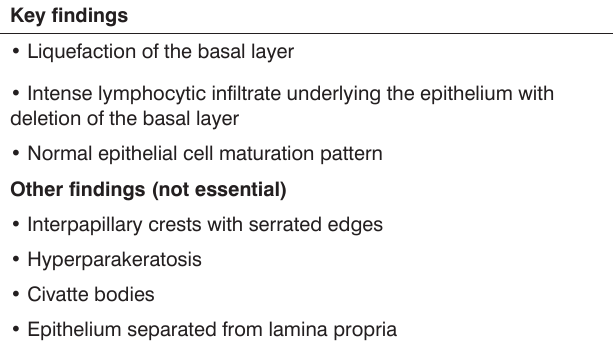
Table 1. Histological diagnostic criteria for oral lichen planus. 13